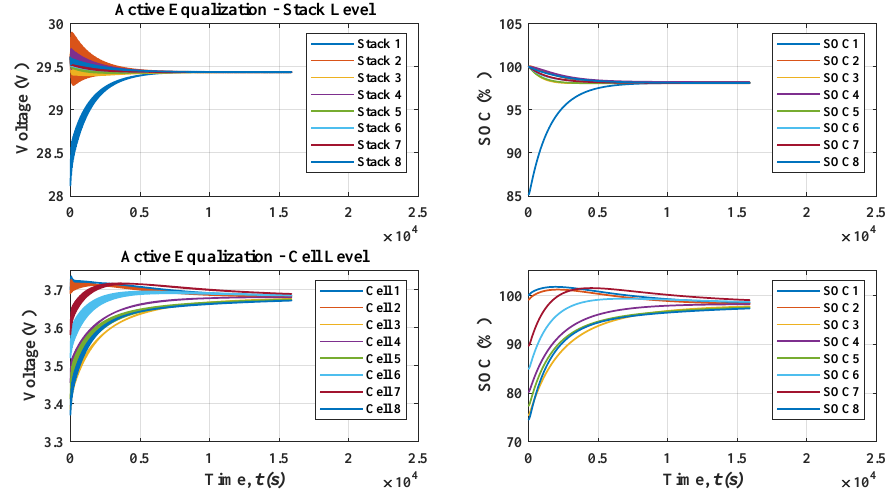
Figure 7. Active equalization at stack and cell levels.